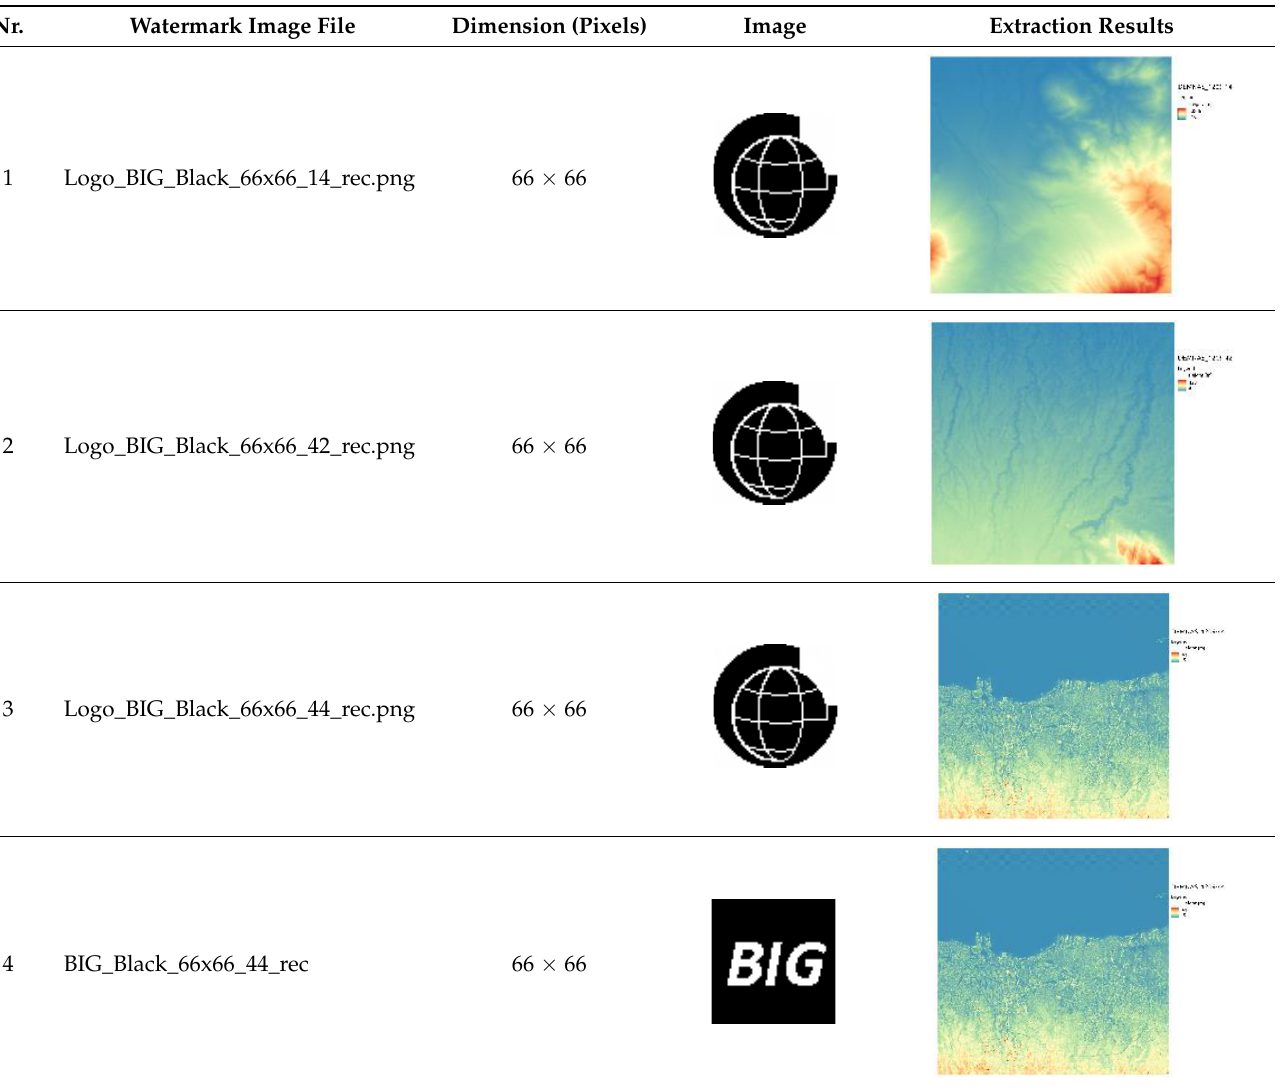
Table 12. BIG’s logo used on the DWT and DCT combination.